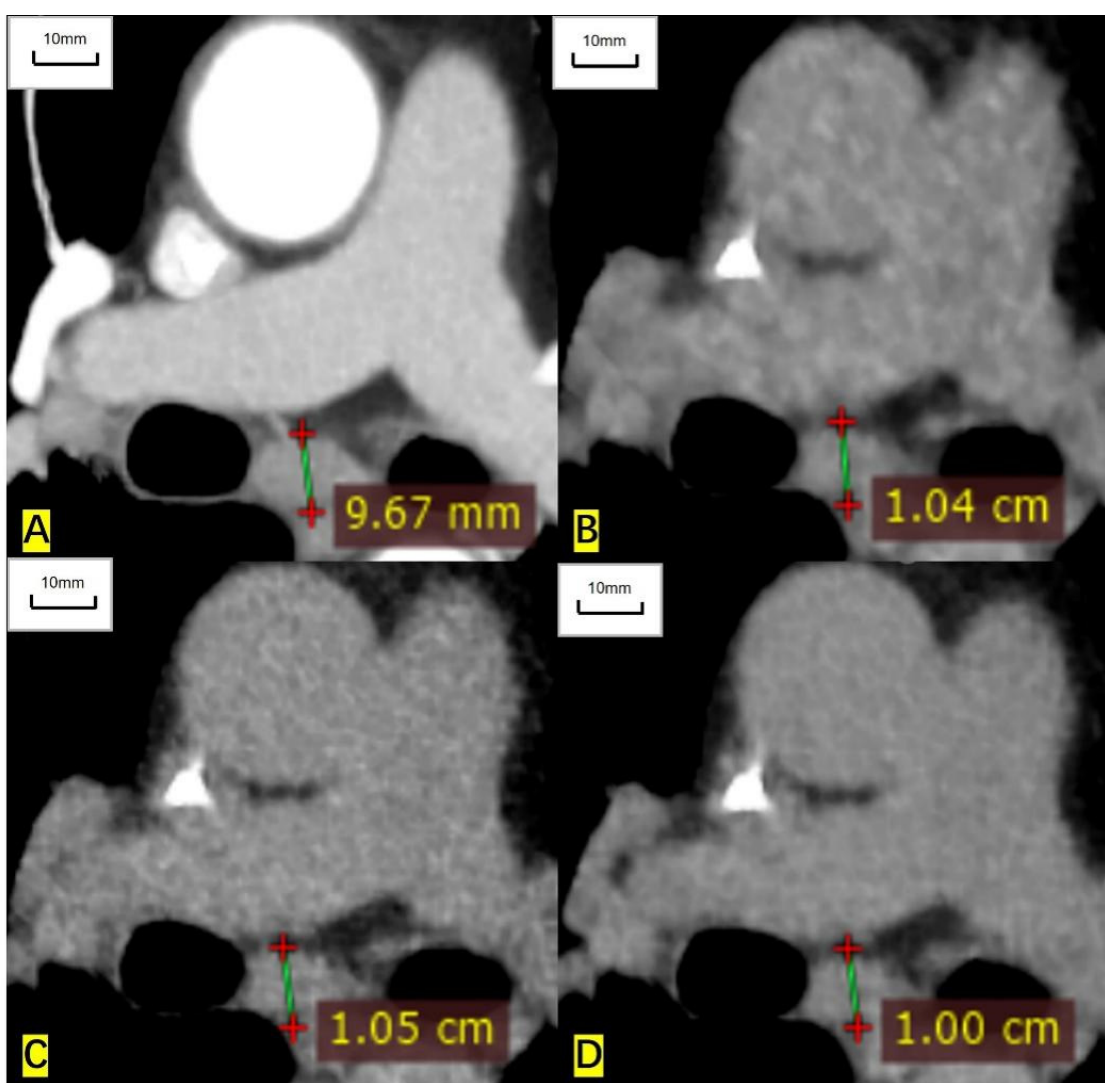
Figure 5. A 65-year-old man had an enlarged subcarinal lymph node, and the histological result Figure 5. A 65 ‐ year ‐ old man had an enlarged subcarinal lymph node, and the histological result was was unavailable. ( A ) The short diameter measured on the contrast-enhanced CT image is 9.67 mm. unavailable. ( A ) The short diameter measured on the contrast ‐ enhanced CT image is 9.67 mm. ( B ) ( B ) The measured short diameter on the ASIR-V-80% reconstructed image is 10.4 mm. ( C ) The The measured short diameter on the ASIR ‐ V ‐ 80% reconstructed image is 10.4 mm. ( C ) The measured measured short diameter on the DLIR-M image is 10.5 mm. ( D ) The measured short diameter on the